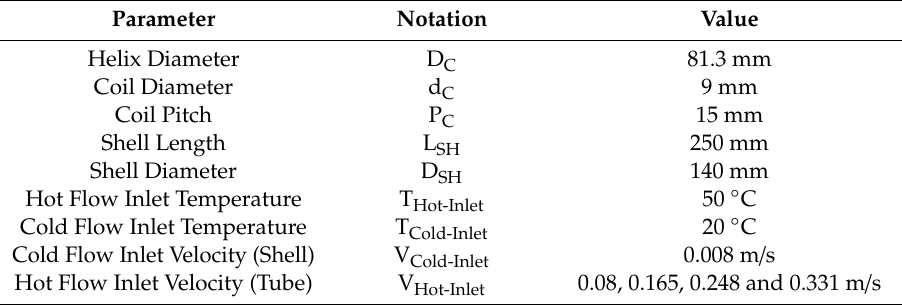
Table 1. Operational and geometrical parameters for the validation case of Jamshidi et al.